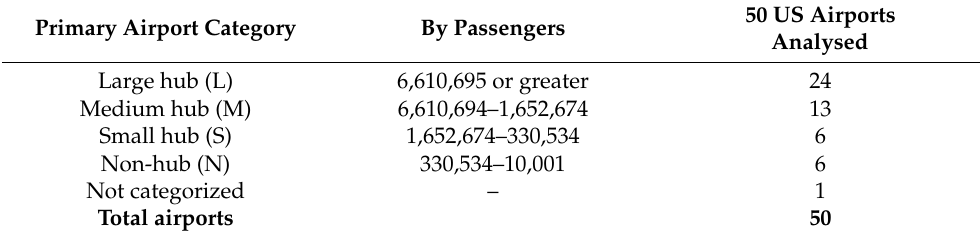
Table 1. Airport category.